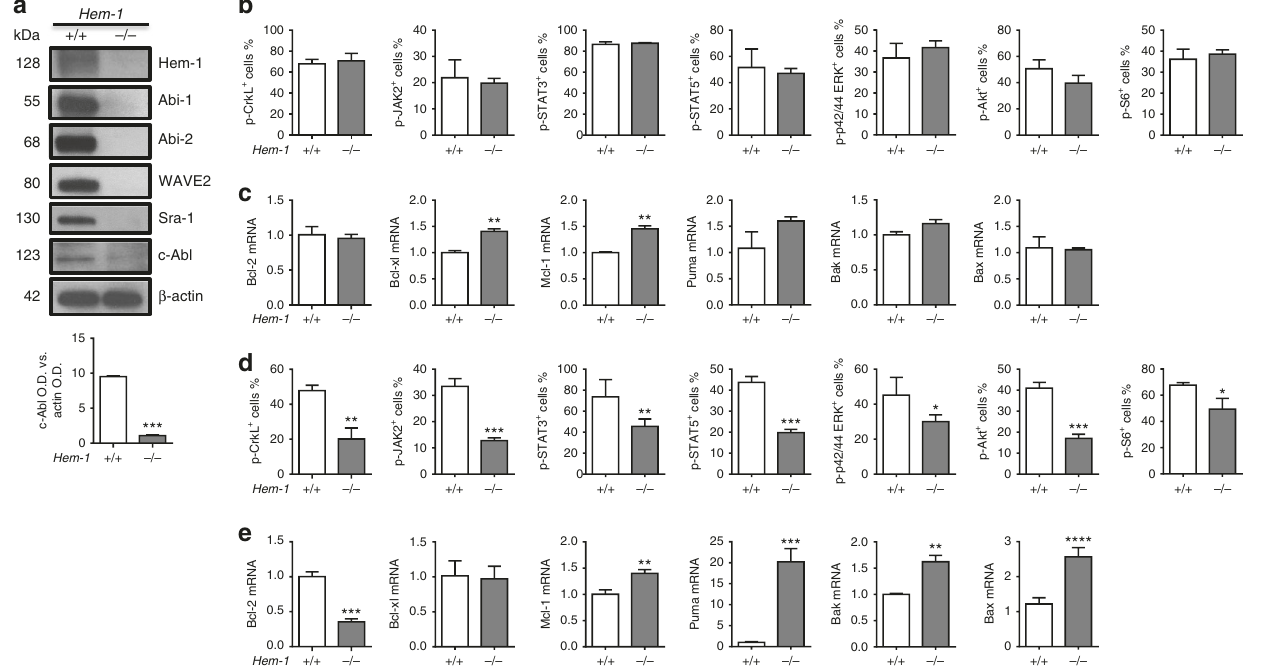
Fig. 5 A defect in c-Abl signaling contributes to the impairment of Hem-1 − / − HSCs. a As expected, depletion of Hem-1 protein results in degradation of other WAVE2 components such as Abi-1, Abi-2, WAVE2, and Sra-1. Expression of c-Abl protein was also decreased in Hem-1 − / − E14.5 CD45 + Lin − FL cells as measured by western blot. β -Actin was used as a loading control. Optical density (OD) averages of c-Abl signal normalized to actin (±S.D.) of three distinct western analyses ( n = 3, *** p < 0.001, Student ’ s t test). b Flow cytometric analysis of the phosphorylation of downstream effectors of the c-Abl signaling pathway in E14.5 CD45 + Lin − FL cells found no differences compared to littermate Hem-1 + / + cells ( n = 9). c Quantitative RT-PCR expression analysis of regulators of apoptosis between Hem-1 + / + and littermate Hem-1 − / − E14.5 CD45 + Lin − FL ( n = 9, ** p < 0.01, Student ’ s t test). d The phosphorylation of c-Abl downstream signaling pathway effectors in Hem-1 − / − PD3 Lin − BM cells was reduced compared to littermate Hem-1 + / + equivalent cells ( n = 9, * p < 0.05, ** p < 0.01, *** p < 0.001, Student ’ s t test). e , Quantitative RT-PCR expression analysis of regulators of apoptosis found that pro-apoptotic effectors were increased and anti-apoptotic effectors were decreased in Hem-1 − / − PD3 Lin − BM cells compared to littermate Hem-1 + / + equivalent cells ( n = 9, ** p < 0.01, *** p < 0.001, **** p < 0.0001, Student ’ s t